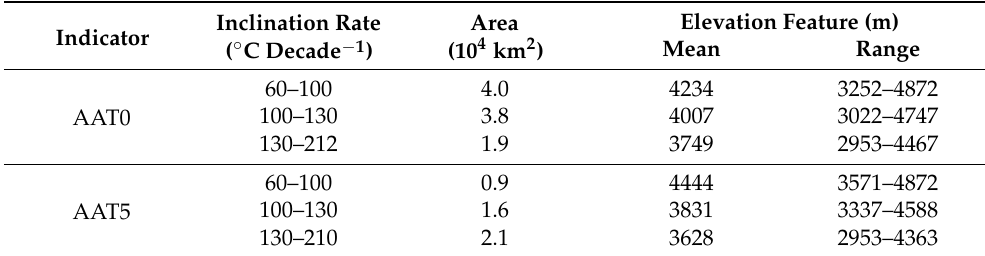
Figure 4. The inclination rate of ≥ 0 °C ( a ) and ≥ 5 °C ( b ) annual accumulated temperature where the determination coefficient R 2 of regression analysis ≥ 0.5 during 1979–2018 in the source region of the Yellow River. Table 5. The area and elevation features of the inclination rates of the AAT with the determination coefficient R 2 of regression analysis ≥ 0.5.